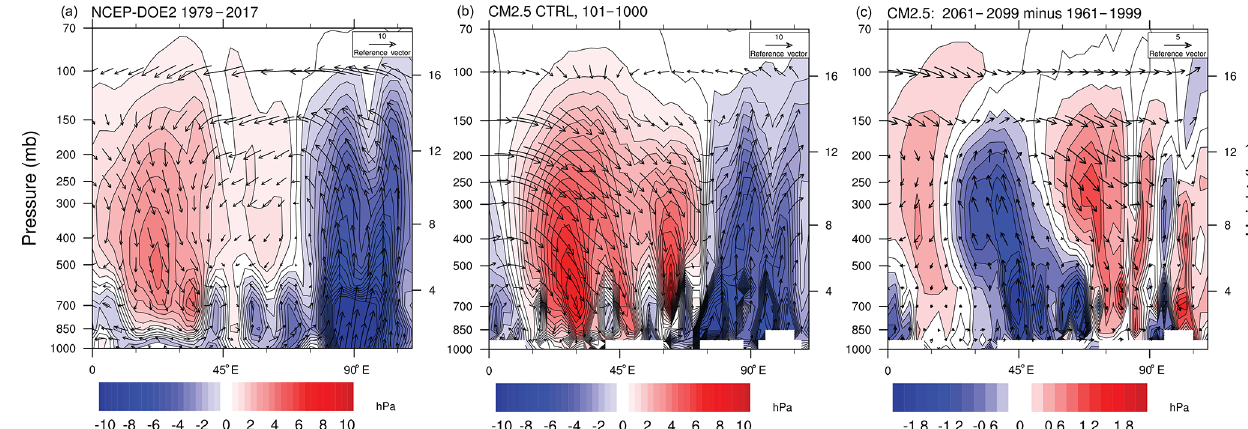
Figure 2. Height (pressure)–longitude cross section of vertical velocity (Pas − 1 ; shaded contours, downward motion denoted with positive values) and the vector of zonal wind (ms − 1 ) and vertical velocity (converted to meters per second and scaled with a factor of 1000) in July. The figure shows time-mean values in July (a) derived for the period 1979–2017 in NCEP-DOE2, (b) derived from 101 to 1000 years of the CTRL run in CM2.5, and (c) projected future changes in the period 2061–2099 in the PROJ ensemble mean compared with the baseline period 1961–1999 in the HIST ensemble mean. All fields are shown on the 2.5 ◦ × 2.5 ◦ horizontal grid and at the original vertical levels, which is common for CM2.5 and